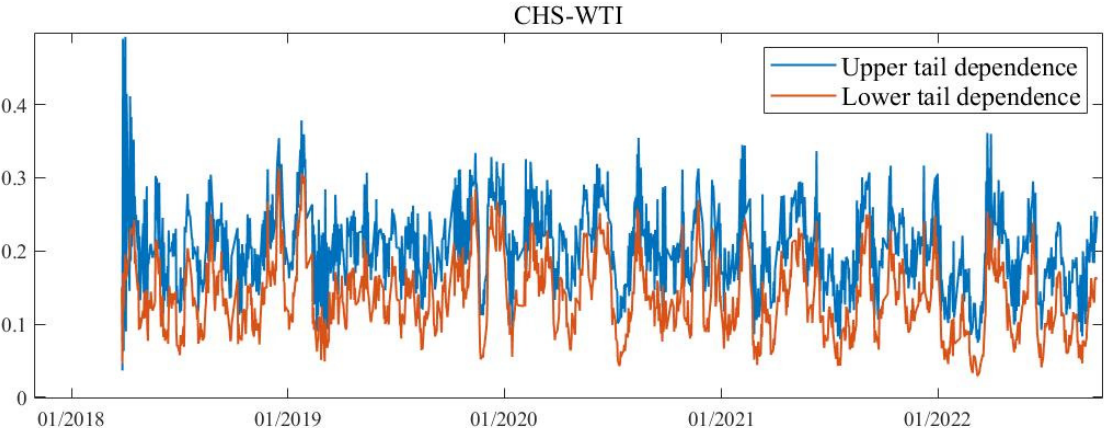
Figure 3. Time-varying tail dependences between Chinese stock and global WTI crude oil futures.